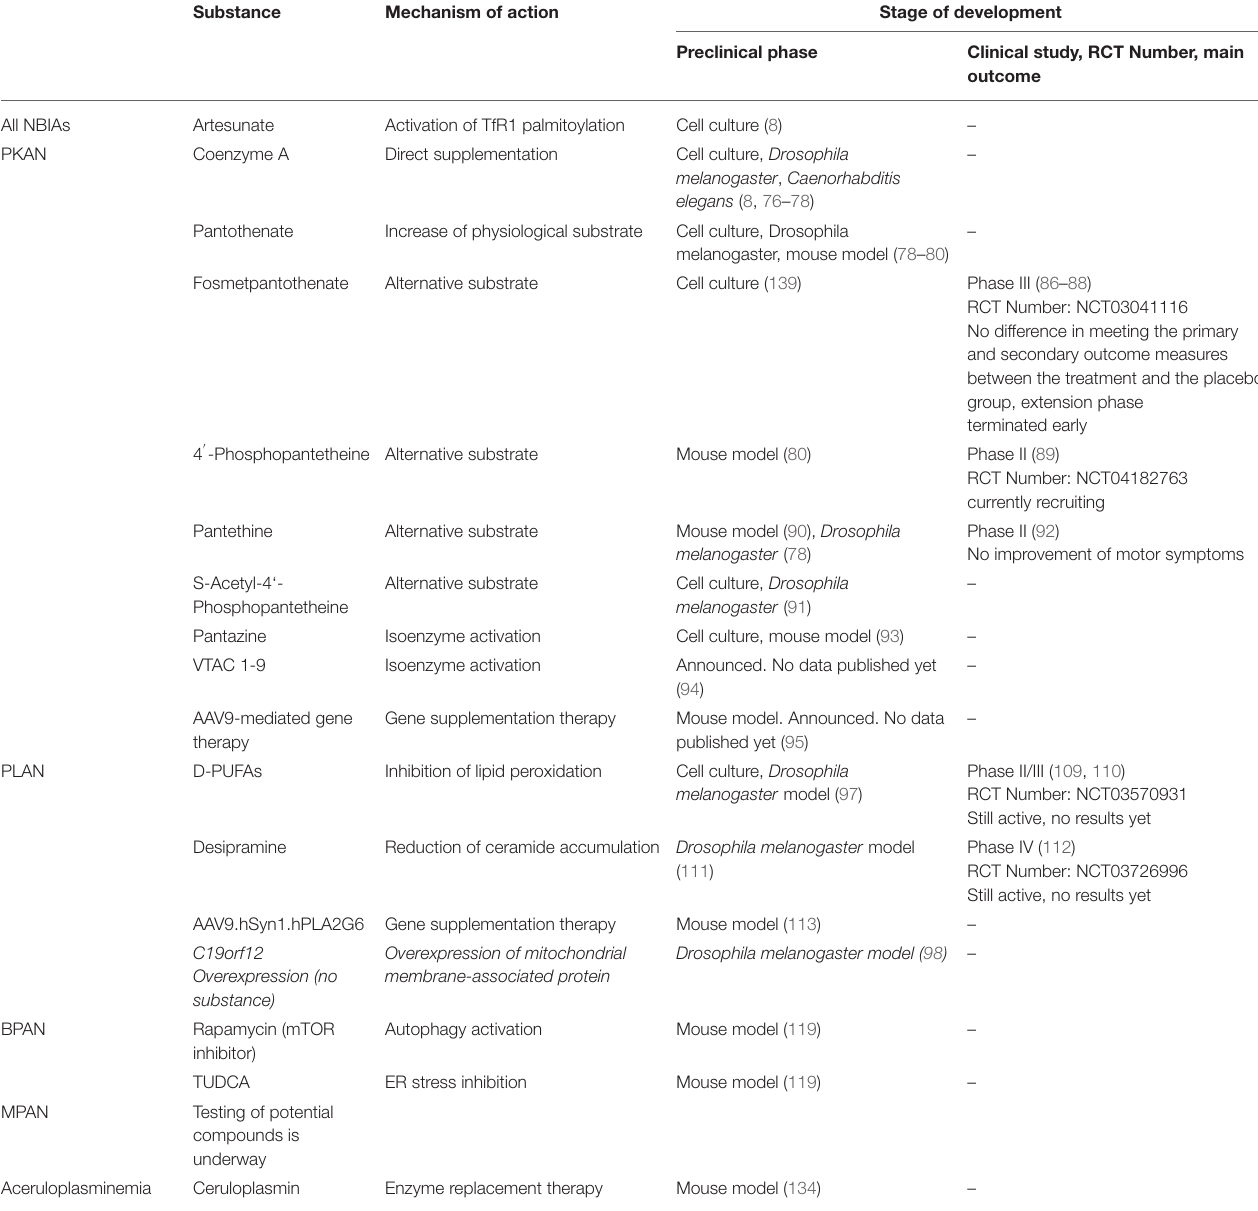
TABLE 1 | Therapeutic strategies beyond iron